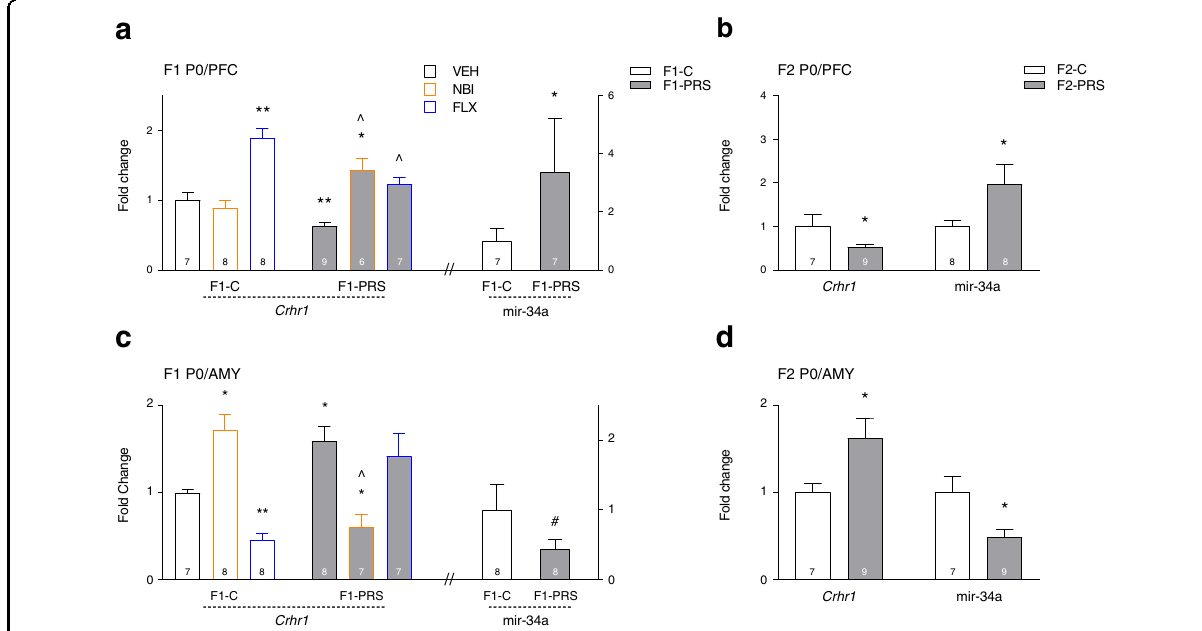
Fig. 3 PRS- and maternal drug treatment-induced gene/miRNA expression changes in neonate PFC and AMY of F1 and F2 offspring. a Maternal PRS decreases Crhr1 in PFC of neonate F1 offspring. This effect is normalized by post-PRS maternal treatment with FLX and NBI, which increases Crhr1 mRNA beyond control levels. Maternal FLX increases Crhr1 expression in F1-C (2 × 3 ANOVA, group × drug F 2,39 = 15.1, p < 0.00001). Maternal PRS also increases mir-34a expression in F1-VEH PFC (one-way ANOVA, F 1,12 = 5.6, p < 0.05). b As in F1-VEH animals, PRS decreases Crhr1 mRNA (one-way ANOVA, F 1,14 = 8.1, p < 0.05) and increases mir-34a expression (F 1,14 = 7.7, p < 0.05) in PFC of neonate F2 offspring. c Maternal PRS increases Crhr1 mRNA in AMY of neonate F1 offspring. This effect is normalized by post-PRS treatment with NBI, which decreases Crhr1 mRNA beyond control levels (2 × 3 ANOVA, group × drug F 2,39 = 29.2, p < 0.00001). Maternal PRS also marginally decreases mir-34a expression in F1-VEH AMY (one- way ANOVA, F 1,14 = 4.002, p = 0.065). d PRS increases Crhr1 mRNA (one-way ANOVA, F 1,14 = 8.04, p < 0.05) and decreases mir-34a expression (one- way ANOVA, F 1,14 = 6.5, p < 0.05) in AMY of neonate F2 offspring. Data presented as means and standard errors of fold-change relative to F1-C/VEH ( a , c ) or F2-C ( b , d ). Post-hoc/one-way ANOVA # p < 0.075, * p < 0.05, ** p < 0.001, ^ p < 0.05, post-hoc relative to